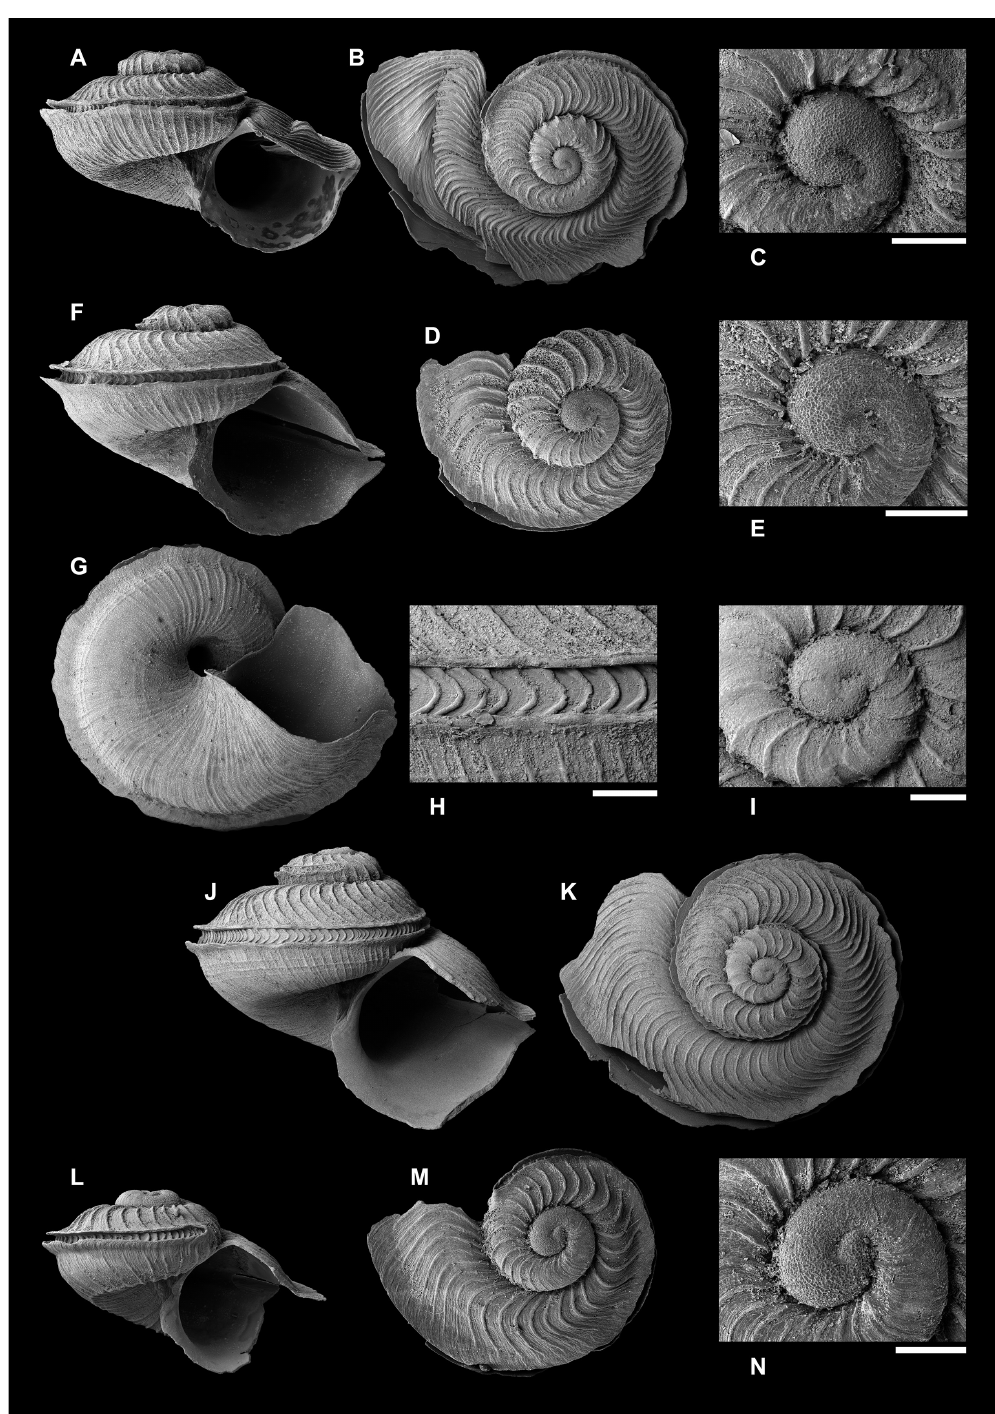
Fig. 5. Anatoma declivis sp. nov. A–C . Paratype 1 (SMF 358985), I19_Ma_92, INDEX19_031RO, H 1.21, W 1.90 mm, Ha 0.77 mm, Wp 0.19 mm. D–E . Paratype 2 (SMF 358986), I19_Ma_93, INDEX19_031RO, W 0.87 mm, Wp 0.20 mm. F–G . Holotype (SMF 358984), I19_Ma_94,